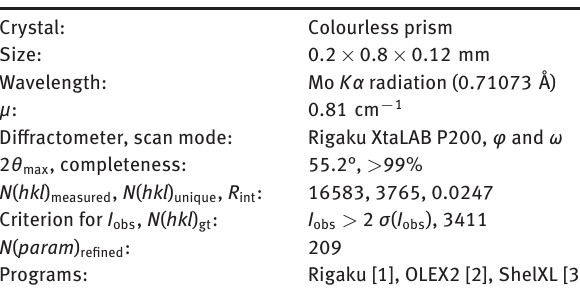
Table 1: Data collection and handling.